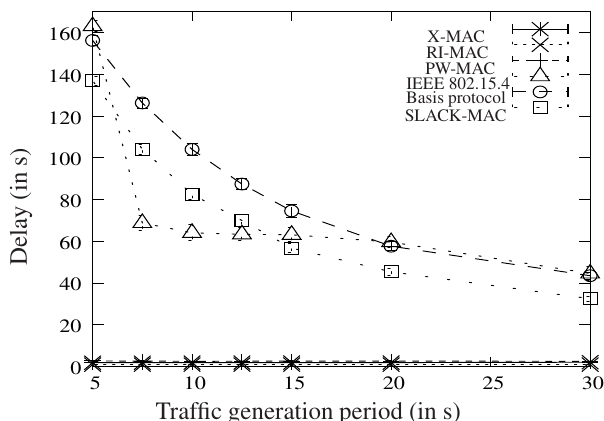
Figure 7. End-to-end delay of data packets as a function of the traffic generation period, for a duty-cycle of 1 %, and for several